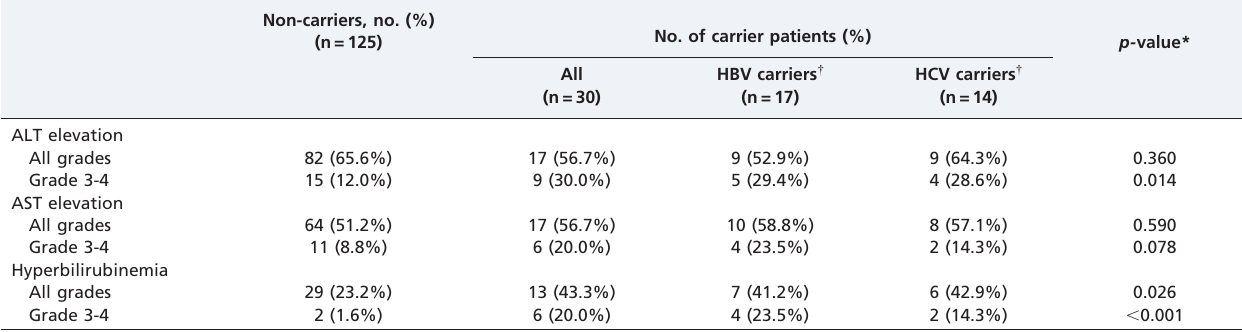
Table 3 - Incidence of hepatic adverse events among 155 patients with multiple myeloma. Non-carriers, no. (%)